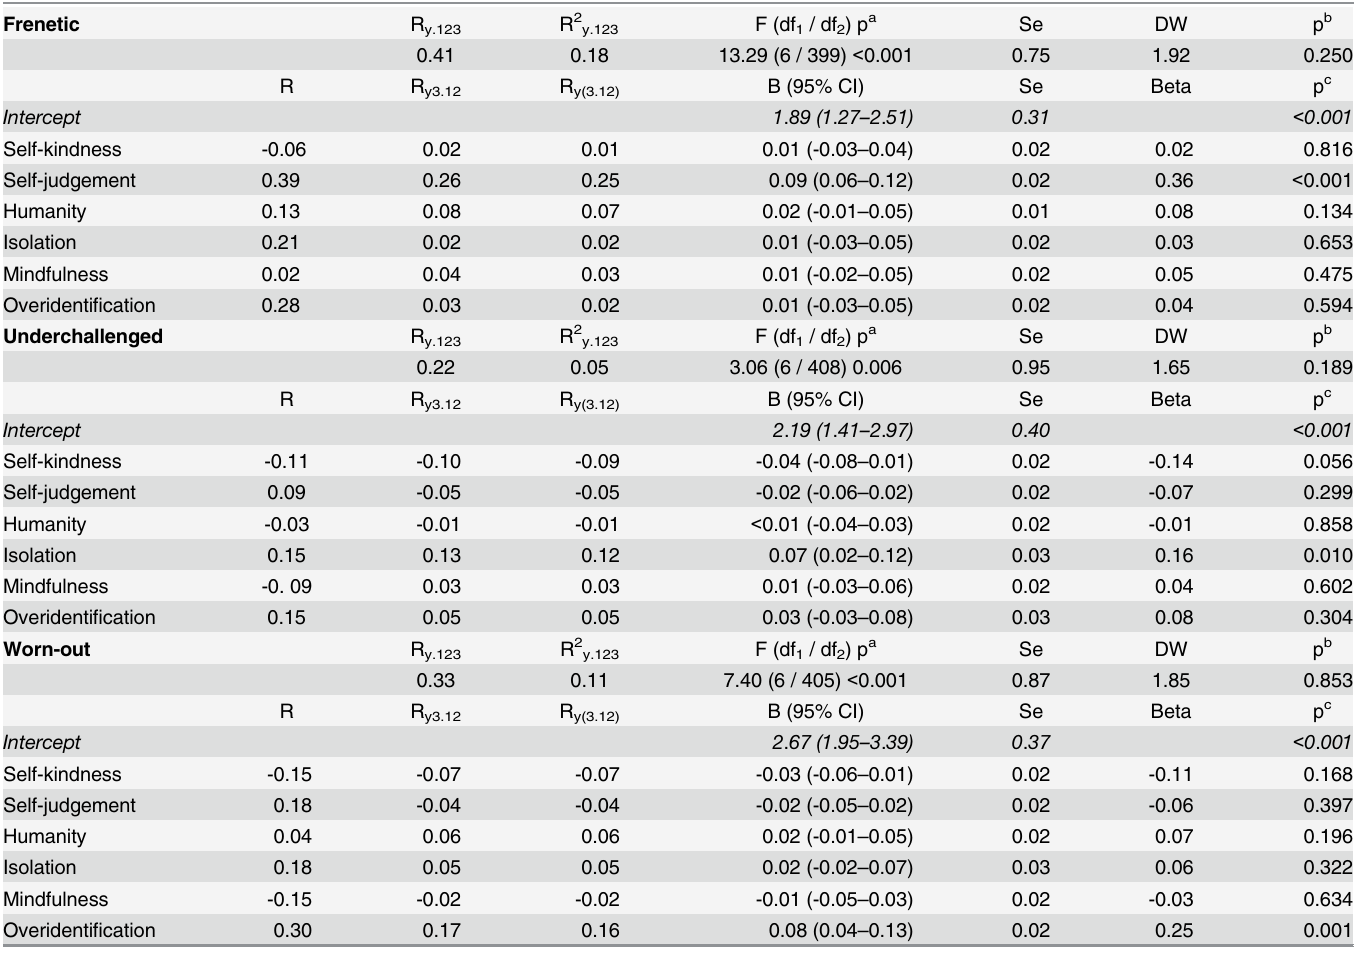
Table 3. Explanatory power of self-compassion with regard to the burnout